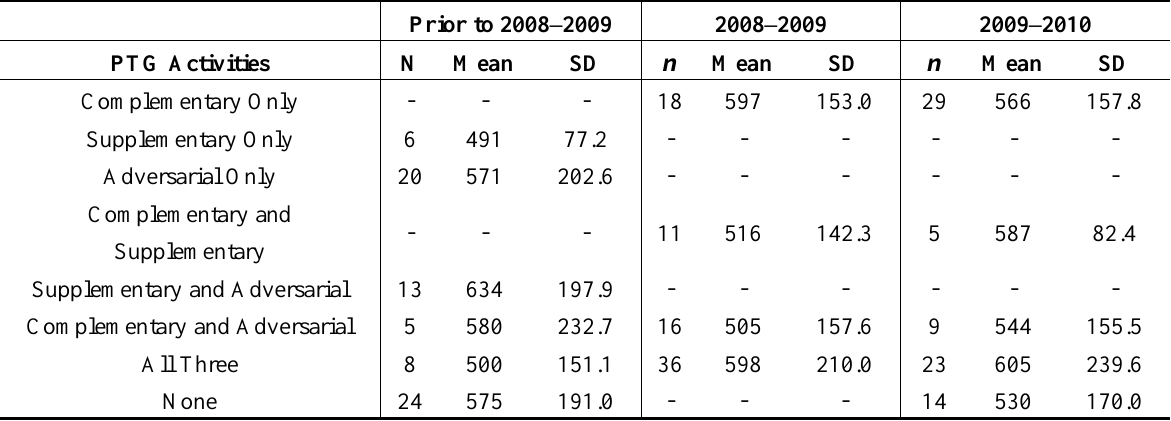
Table 2. Mean number of students by PTG activities and time